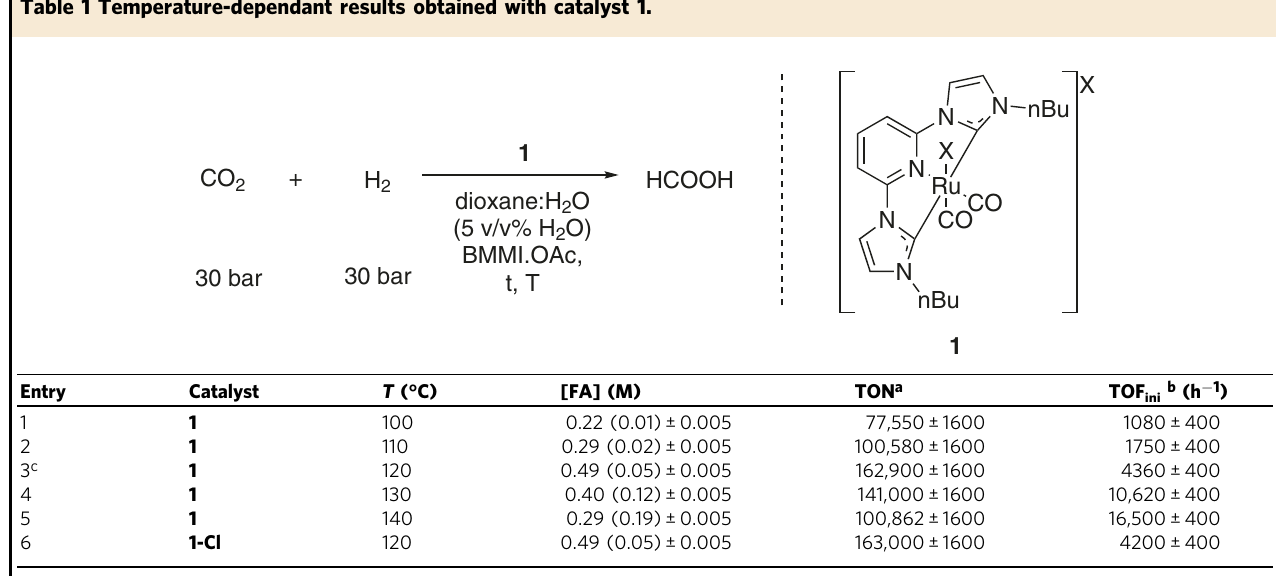
b Determined after 4h of reaction time. c Data reproduced two times, error values within the error margin of the NMR determination, which were used as the standard